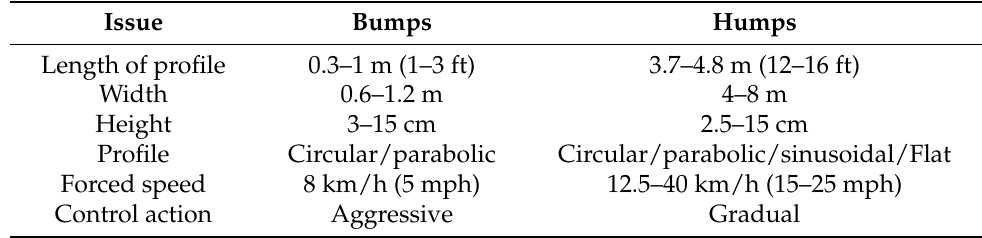
Table 2. Contrasts between bumps and humps.